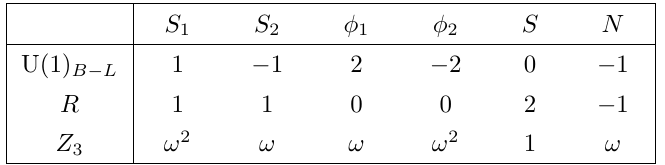
Table 1 . U(1) B − L and R charge assignments for different superfields S 1 , S 2 , φ 1 , φ 2 , S, N in the inflation